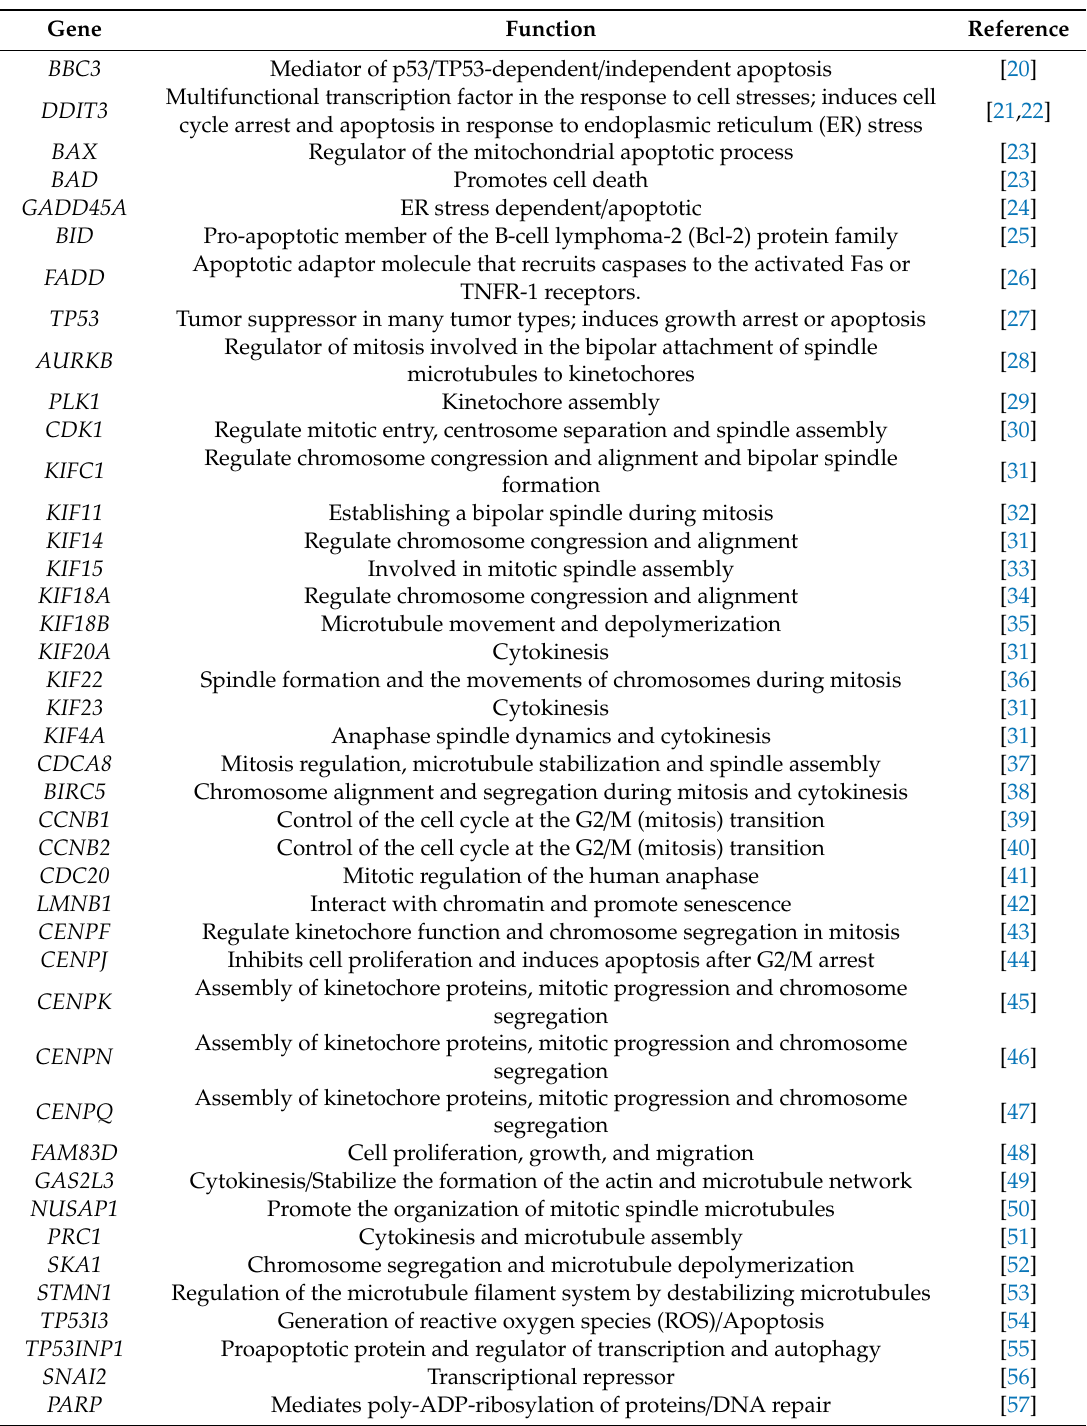
Table 1. Function of genes being significantly changed upon C-1305 treatment ( p < 0.05) as assigned with the Gene Ontology databases and verified with the